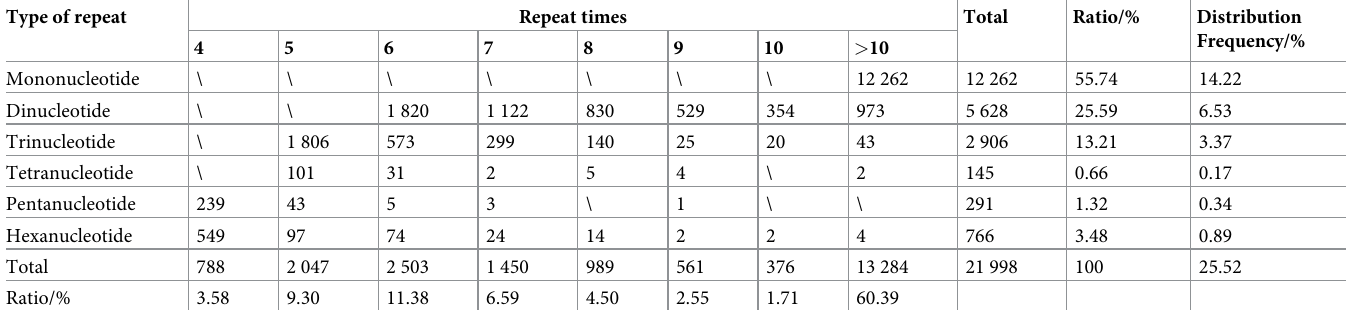
Table 2. The number and distribution frequency of SSR types in Paeonia .